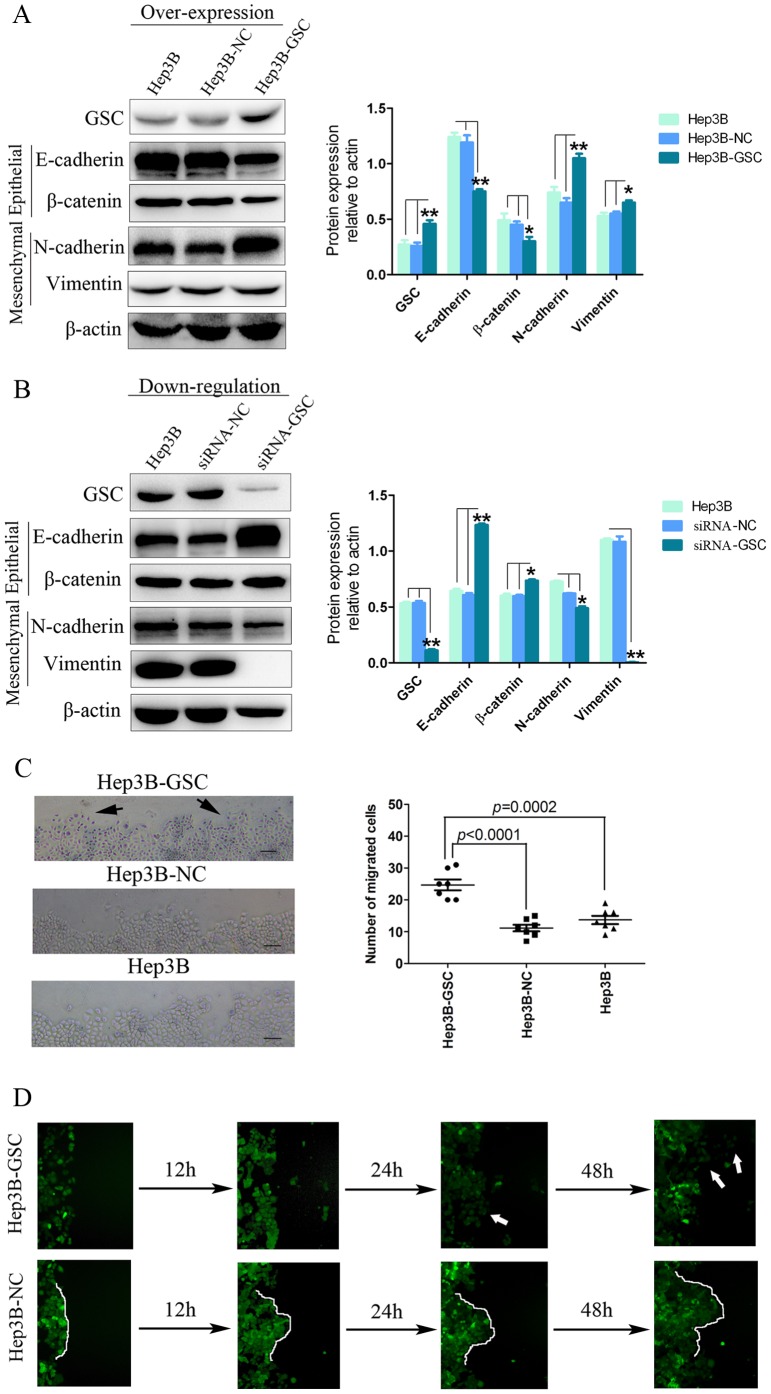
GSC induces EMT but not collective cell migration of HCC cells.(A) Ectopic expression of GSC in Hep3B cells induced changes in expression of EMT markers, particularly E-cadherin. The expression of each protein was normalized to β-actin. Results were analyzed using Student's t test. (*, P<0.05; **, P<0.01) ANOVA analysis also indicated significant differences among the three groups (P = 0.001 for GSC, P<0.001 for E-cadherin, P = 0.004 for β-catenin, P<0.001 for N-cadherin, and P = 0.007 for vimentin). In addition, post hoc analysis confirmed the significant difference between Hep3B-GSC cells and Hep3B cells without treatment or treated with negative control. (B) Downregulation of GSC in Hep3B cells reversed the changes in expression of EMT markers as detected by Western blot. Results were analyzed using Student's t test. (*, P<0.05; **, P<0.01) ANOVA analysis also indicated significant differences among the three groups (P<0.001 for GSC, P<0.001 for E-cadherin, P<0.001 for β-catenin, P<0.001 for N-cadherin, and P<0.001 for vimentin). Furthermore, post-hoc analysis confirmed the significant difference between Hep3B-GSC cells and Hep3B cells without treatment or treated with negative control. (C) The scattering cells (black arrow) in the Hep3B-GSC group were prominently increased compared to the control groups. Continuous counting of seven fields of individual migrating cells showed higher numbers of Hep3B-GSC cells migrating than the Hep3B and the Hep3B-NC groups. (D) Fluorescence micrographs of Hep3B cells expressing GSC or GFP control. Hep3B-GSC cells showed decreased cell-cell contact and strong migration of the individual type (white arrows) under continuous observation. Hep3B-NC cells showed characteristic integrated migration (white contour line). (100× original magnification, size bar: 100 µm).